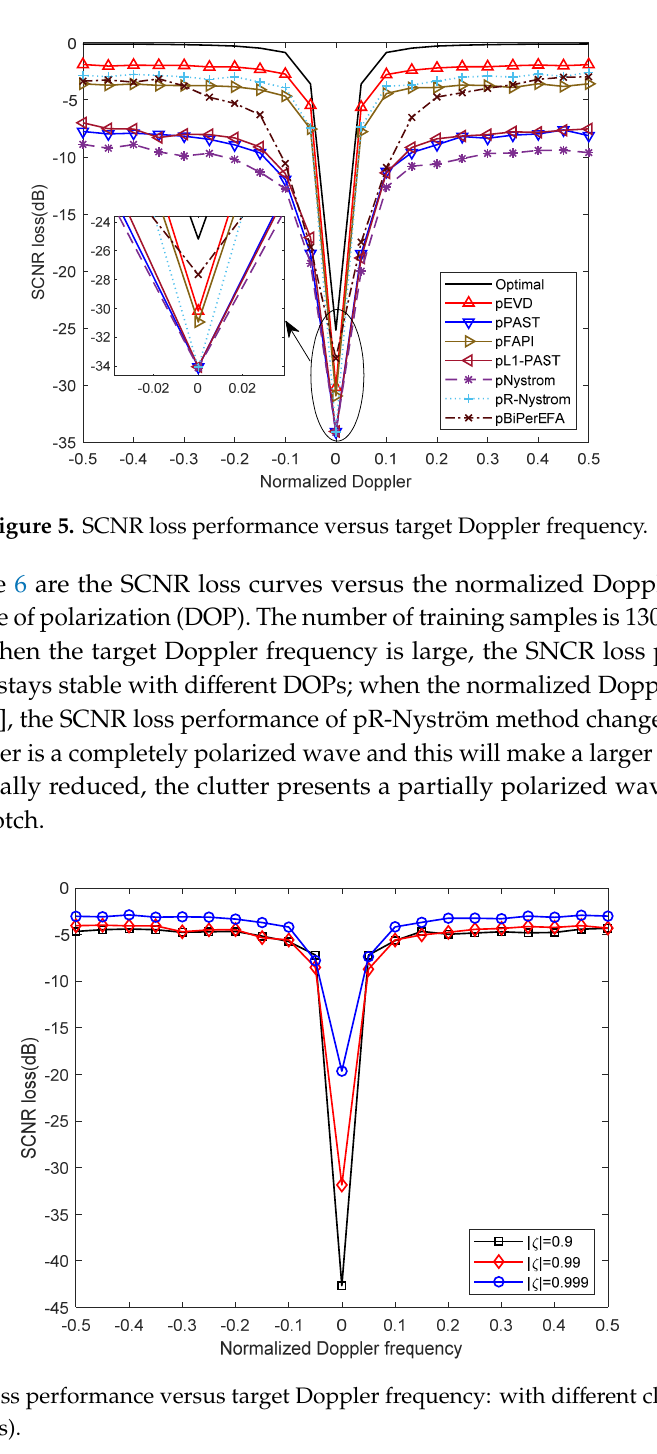
Figure 6. SCNR loss performance versus target Doppler frequency: with different clutter degrees of polarization (DOPs).